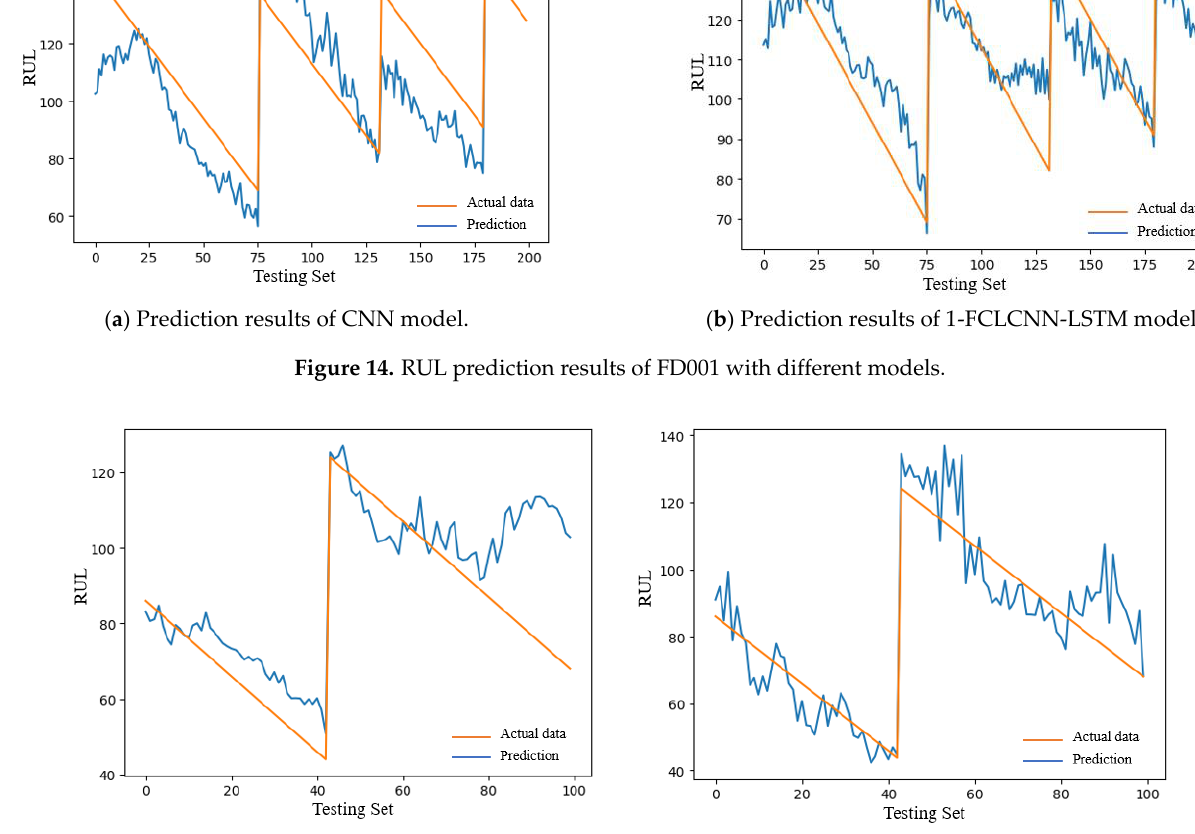
Table 6. RMSE predicted by FD001 and FD003 under the two models. FD001 FD003 CNN 17.22 15.50 FCLCNN-LSTM 11.17